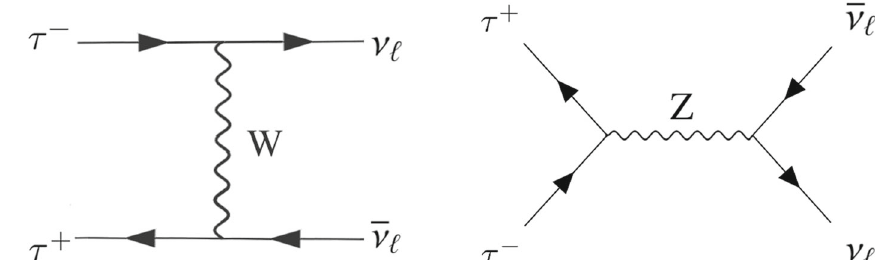
its total annihilation decay width. The numerical values for the exclu- sive e + e − γ and μ + μ − γ modes aregiven for different threshold photon energies, E thr γ > m e ,μ respectively (see text for details)